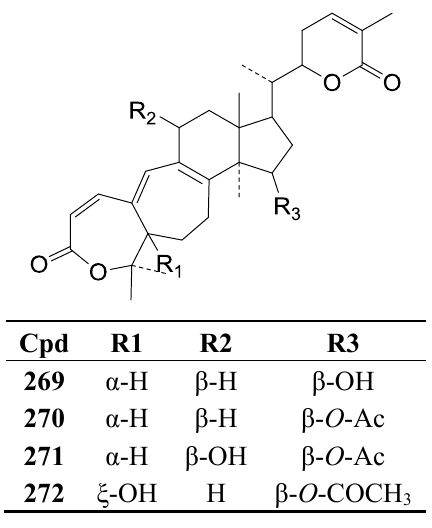
Figure 27. Structures of compounds 269 – 272 .